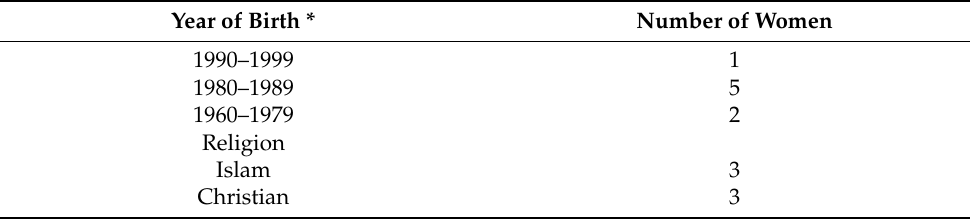
Table 1. Demographic data for interview participants (demographic data missing for one